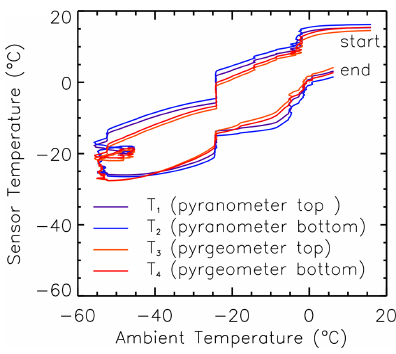
Figure 3. Radiometer sensor temperatures compared to the ambient air temperature measured during the EUREC 4 A flight on 22 January 2020 (flight ID HALO-0122).